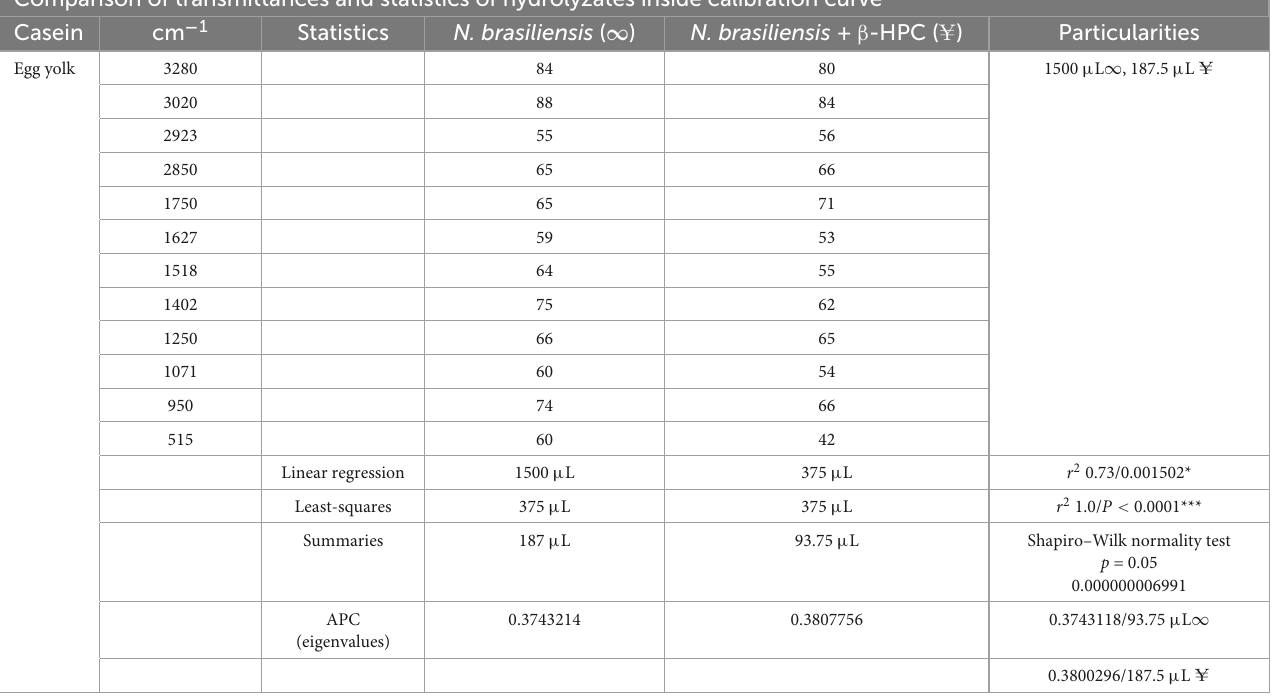
Comparison of transmittances and statistics of hydrolyzates inside calibration curve